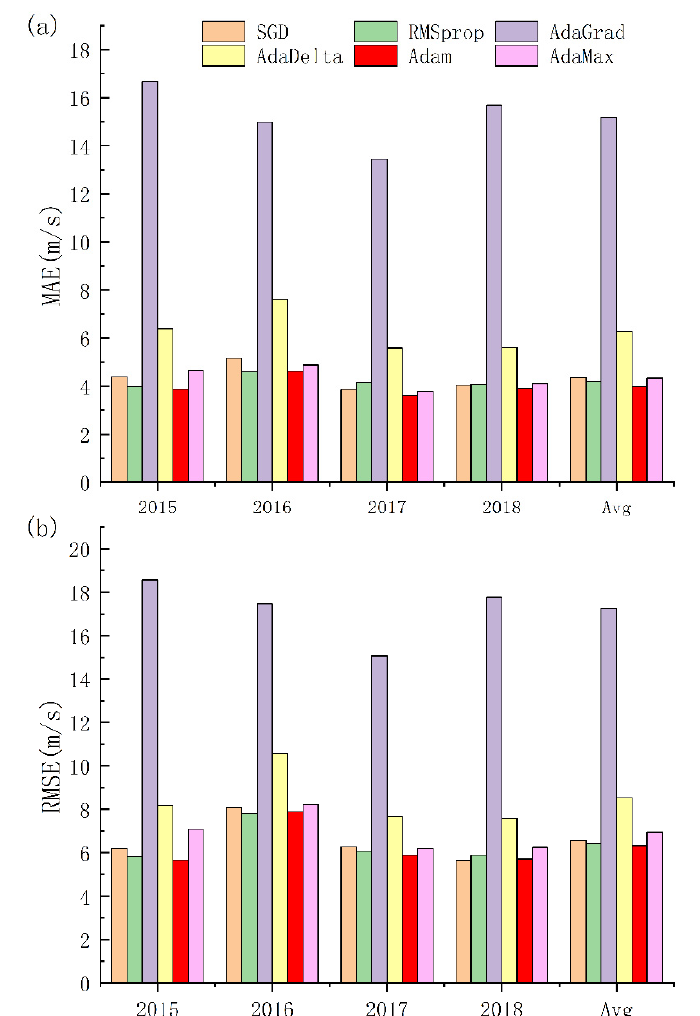
Figure 7. Typhoon intensity forecasting results with different optimizers over 24 h. ( a ) Evaluation of the MAE metric in different years and the four-year average error. Different colored histograms represent different optimizers. The histograms for each optimizer in different years represent typhoon intensity forecasting results in 24 h. The red histograms show the error of the best optimizer forecast for different years. ( b ) Evaluation of the RMSE metric in different years and the four-year average error.